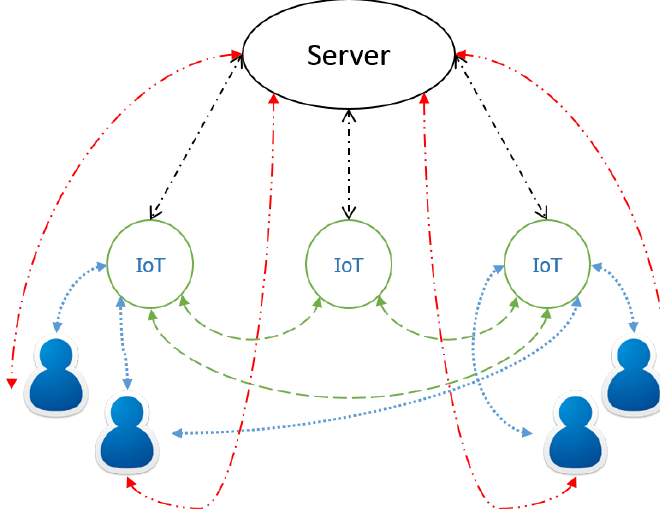
Figure 12. Possible authentications for IoT